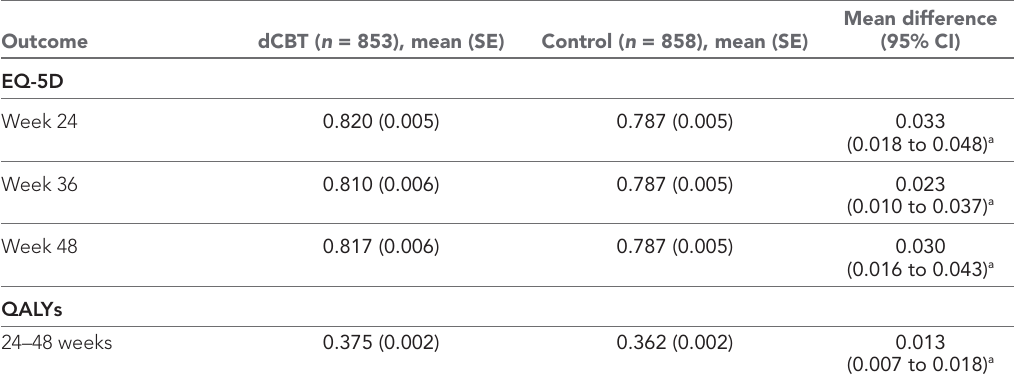
Table 2 EQ- 5D scores and QALYs from 24 weeks to 48 weeks, with multiple imputation used to handle missing